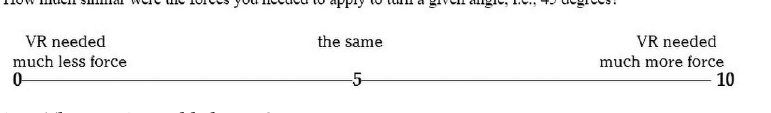
Fig 4. The questions added to IPO.